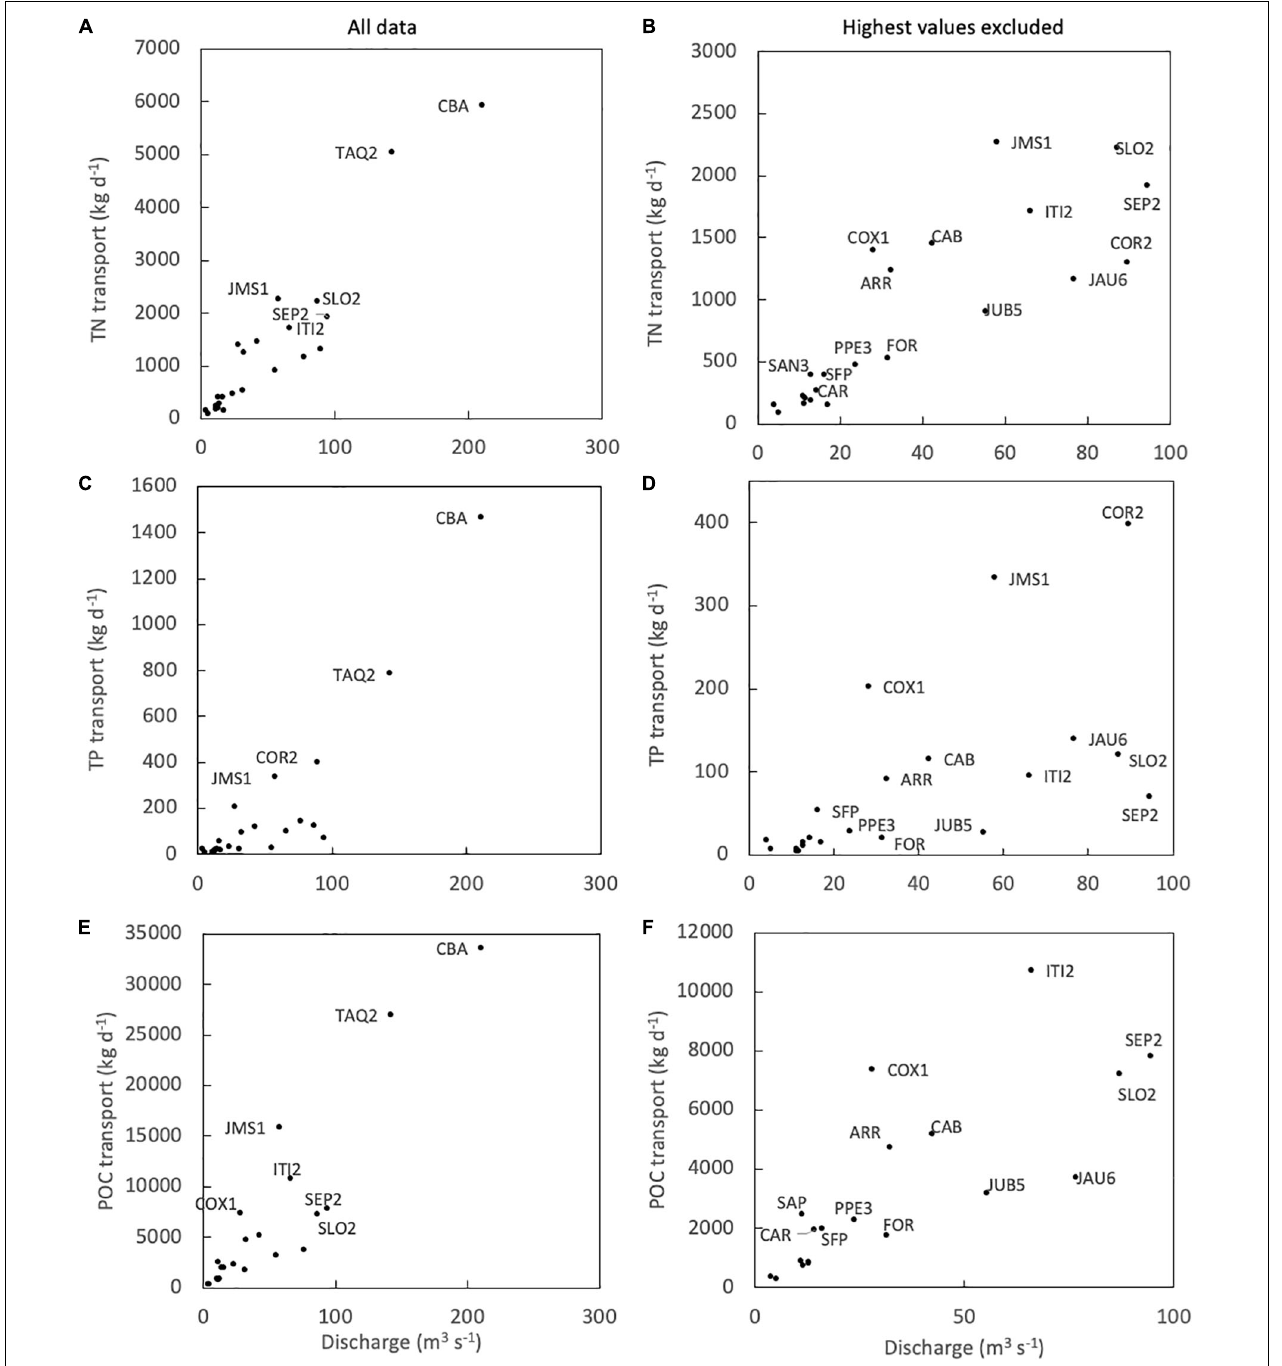
FIGURE 4 | Water-column transport of total nitrogen (TN), total phosphorus (TP), and particulate organic carbon (POC) in relation to river discharge. (A) TN, all data; (B) TN, rivers with discharge < 100 m 3 s -1 ; (C) TP, all data; (D) TP, rivers with discharge < 100 m 3 s -1 ; (E) POC, all data; (F) POC, rivers with discharge < 100 m 3 s -1 . Codes indicate the sampling points detailed in Table 1 . The figure includes both primary and secondary data and reaches with current hydropower facilities as well as reaches targeted for future